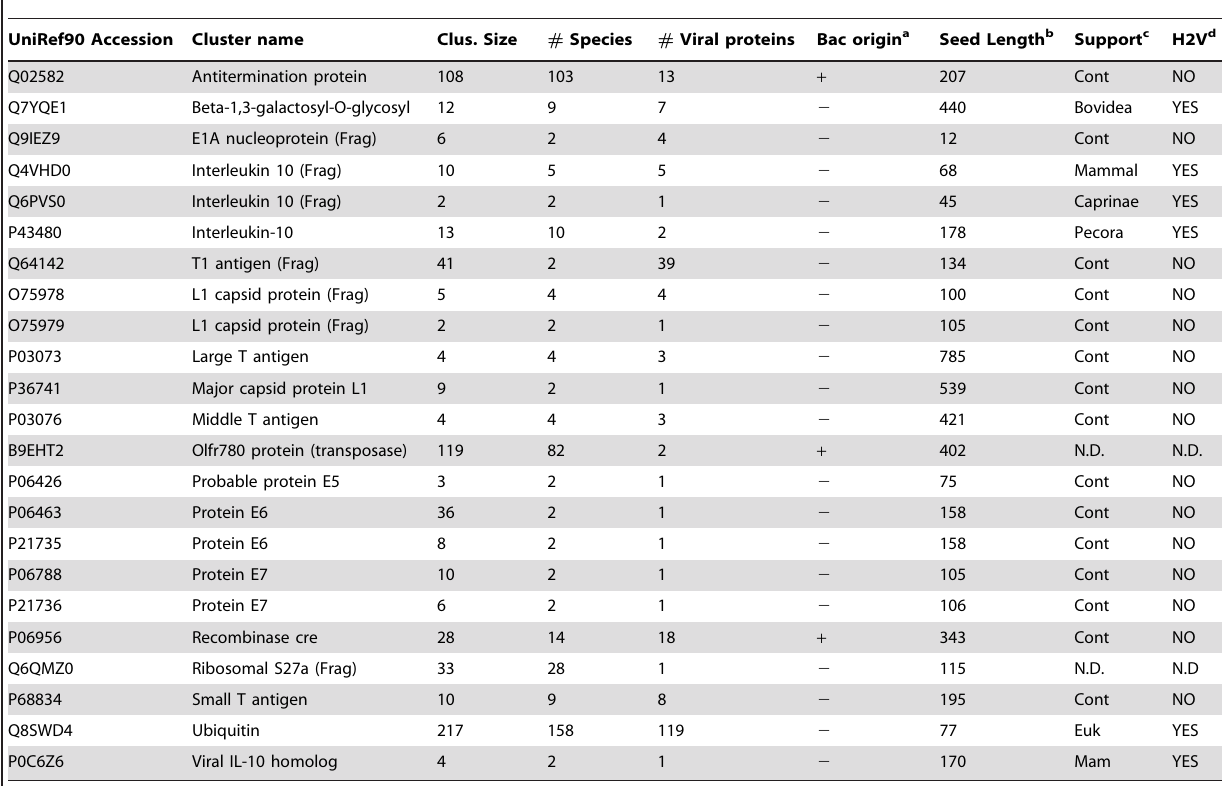
Table 1. List of UniRef90 clusters that include mammals and dsDNA viruses (Class I).